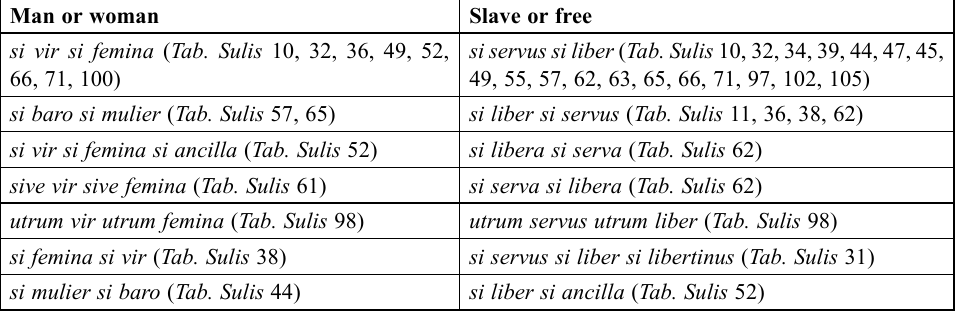
Table 1: The variations of the two most common stock formulae and the curses on which they appear. Man or woman Slave or